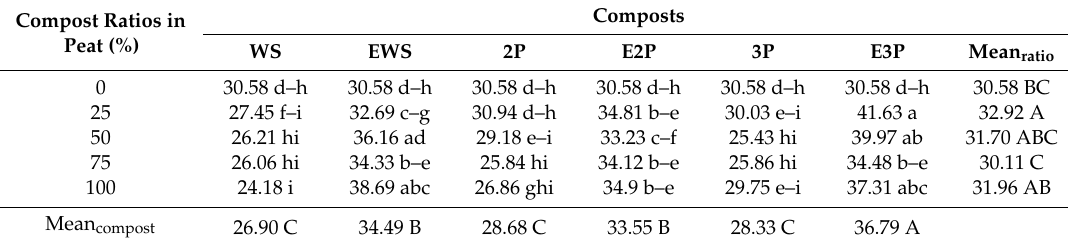
Table 7. E ff ects of the treatments on chlorophyll index values (SPAD).